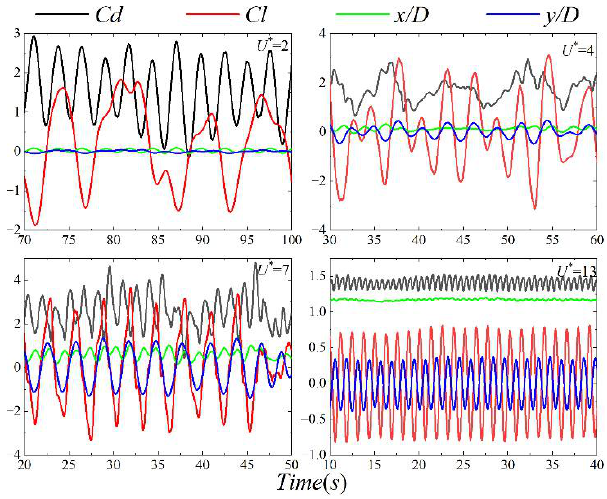
Figure 18. Time history of the force coefficients and displacement for CR 40.